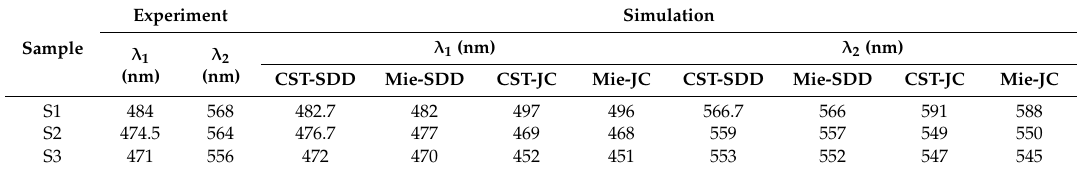
Table 1. Measured and simulated wavelengths of the peak absorption cross-section (ACS) values.